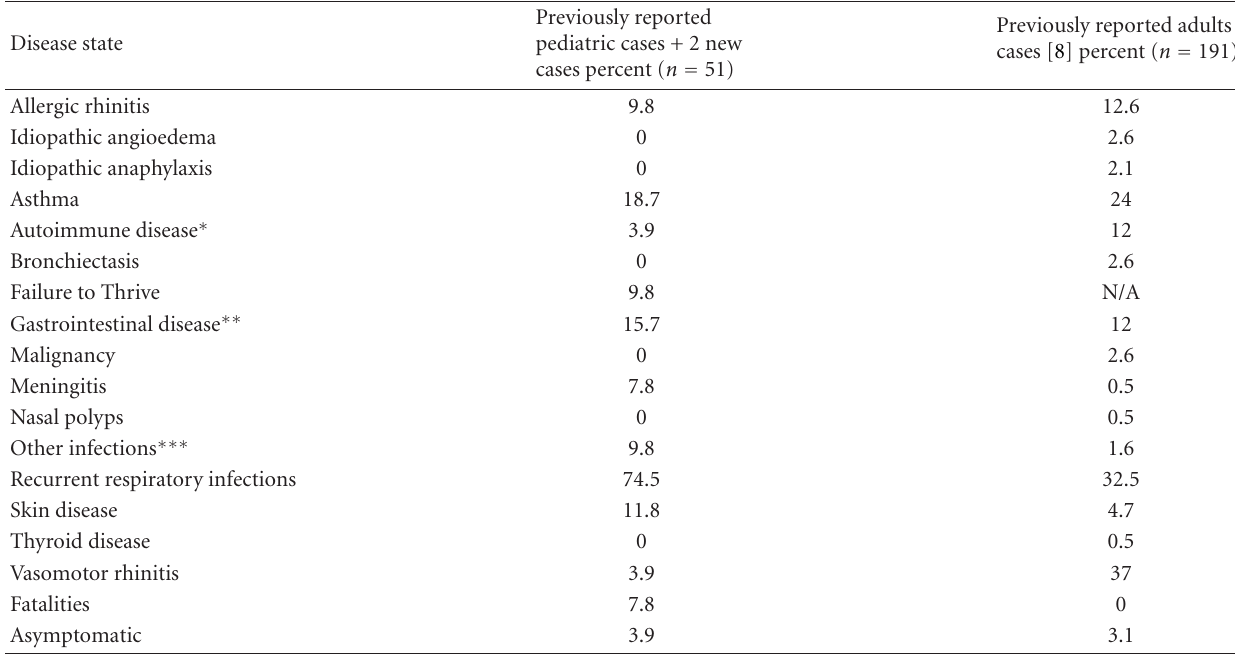
Table 4: Frequencies of comorbid diseases in patients with SIgMID. ( n/a = not applicable). Disease